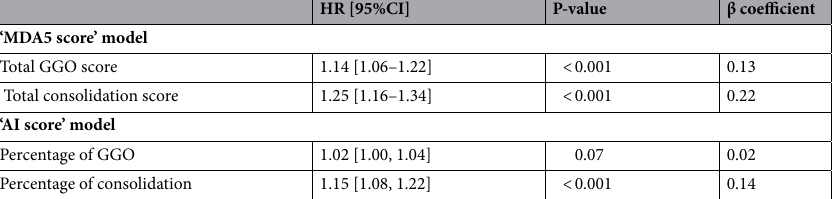
Table 2. Multivariable COX regression analysis for ‘MDA5 score’ and ‘AI score’ models. HR, hazard ratio; 95%CI, 95% confidence interval; MDA5, anti-melanoma differentiation-associated gene 5; AI, artificial intelligence; GGO, ground-glass